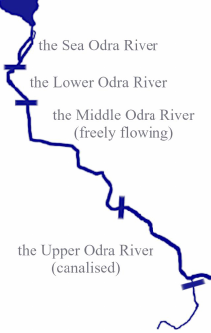
Figure 3. The Odra River sections. Note: In an isolated system, attention can be drawn to 4 sections of the Odra River: the Sea Odra River, the Lower Odra River, the Middle Odra River (freely flowing), and the Upper Odra River (canalized). However, the adoption of such an arrangement would exclude longer routes beyond the boundaries of the section concerned. The network system includes 9 sections of the Odra River, additionally connecting two or more sections into one in the case of transports performed outside the section boundaries from an isolated system, e.g., the Sea Odra River—the Lower Odra River. Transport over longer sections was not decomposed and assigned to sections from an isolated system but to sections from the network system. Source: own elaboration.